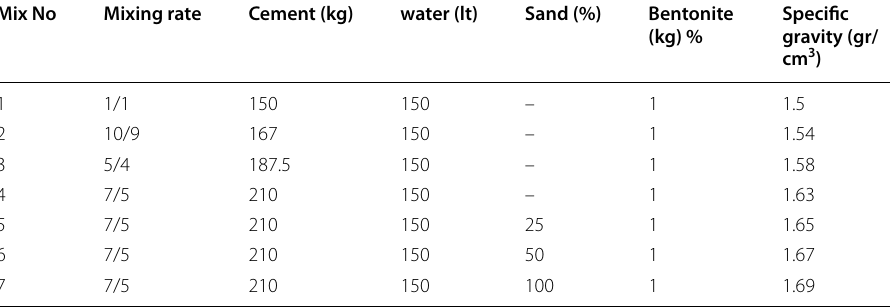
Table 2 Injection grout mixing ratios (CEM II –A of cement, gradation of TSE EN ISO 13500 sand: 95% must pass through sieve no 16, 50% sieve no 50 and 5% < sieve no 200, specific gravity should be > 2 gr/cm 3 ; Prohit